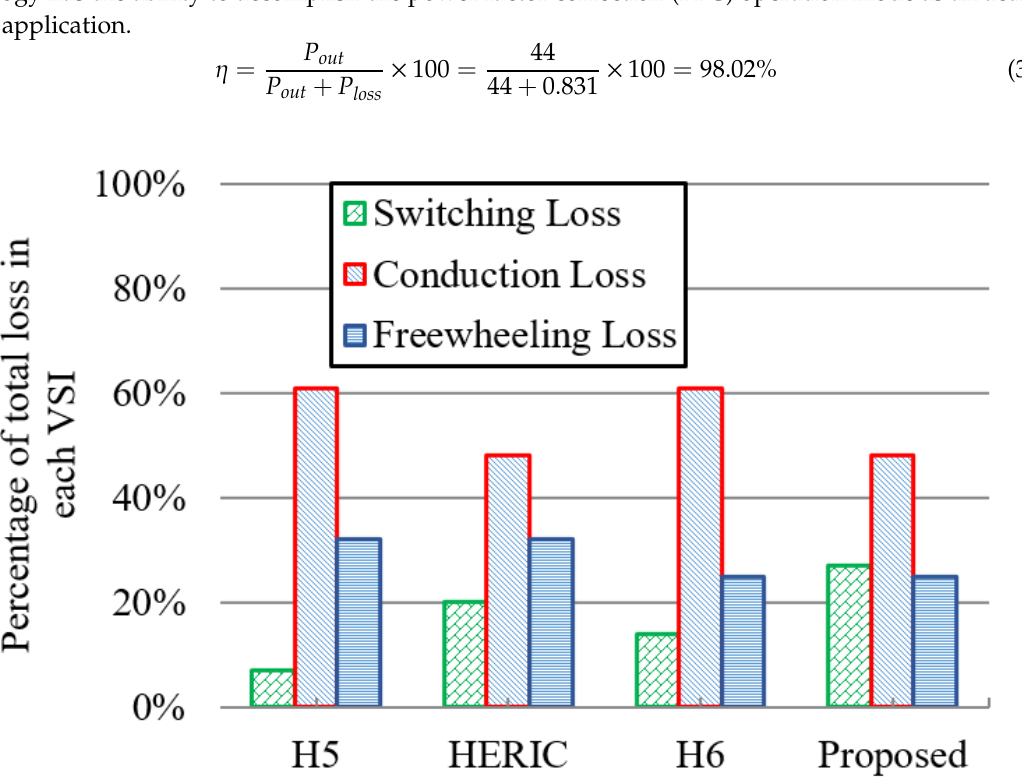
Figure 14. Percentage of self-VSI power loss sharing during operation. VSI: voltage source inverters.